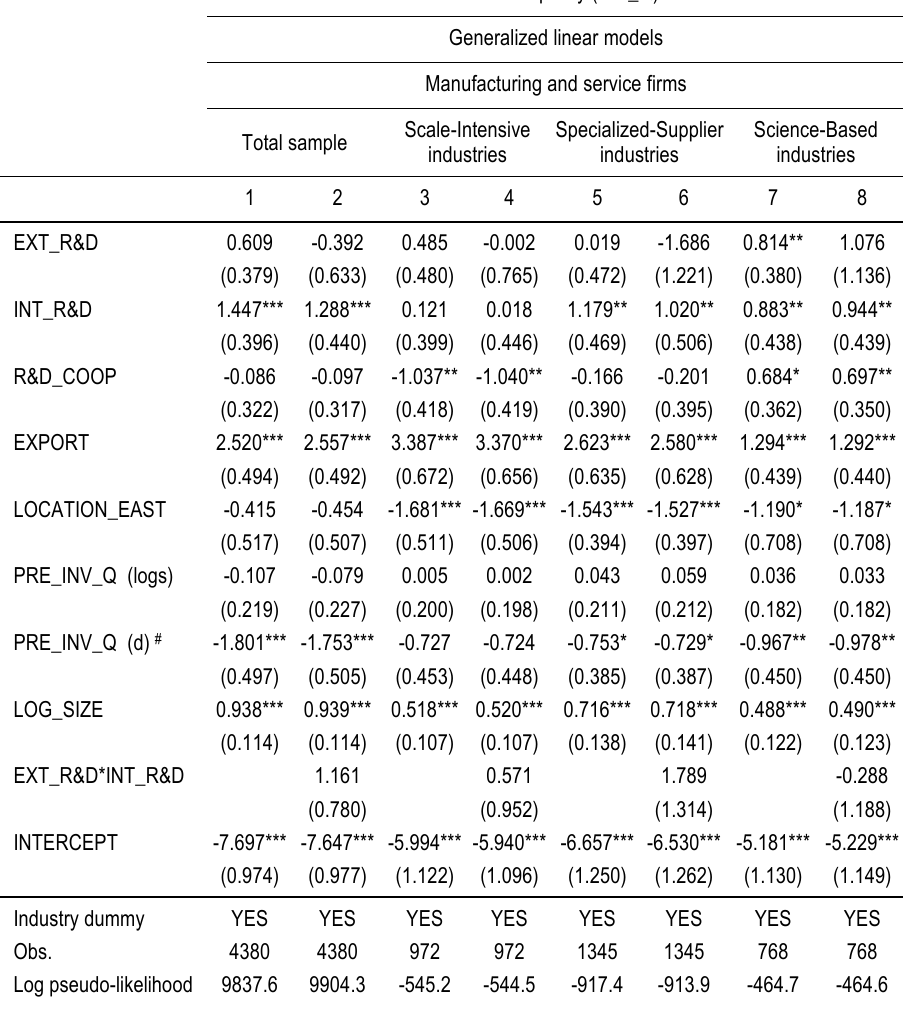
Table 5. Results for invention quality (manufacturing and service sectors together)